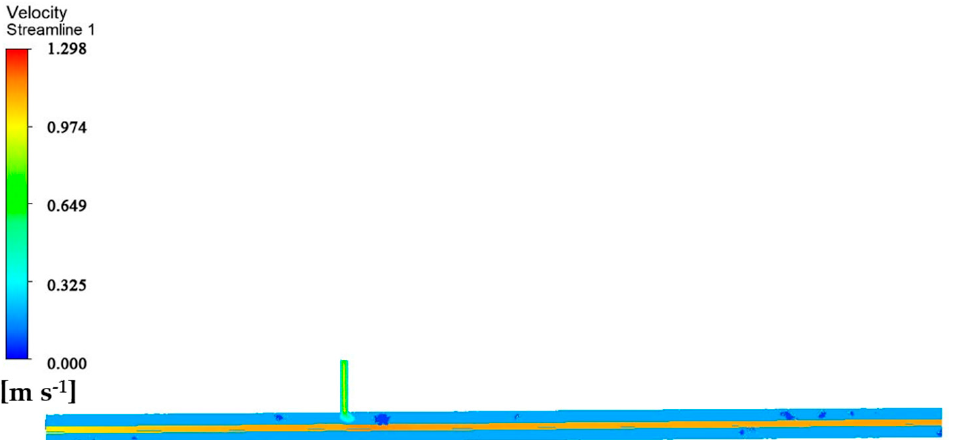
Figure 7. Flow velocity of the longitudinal section at 0.6 s.